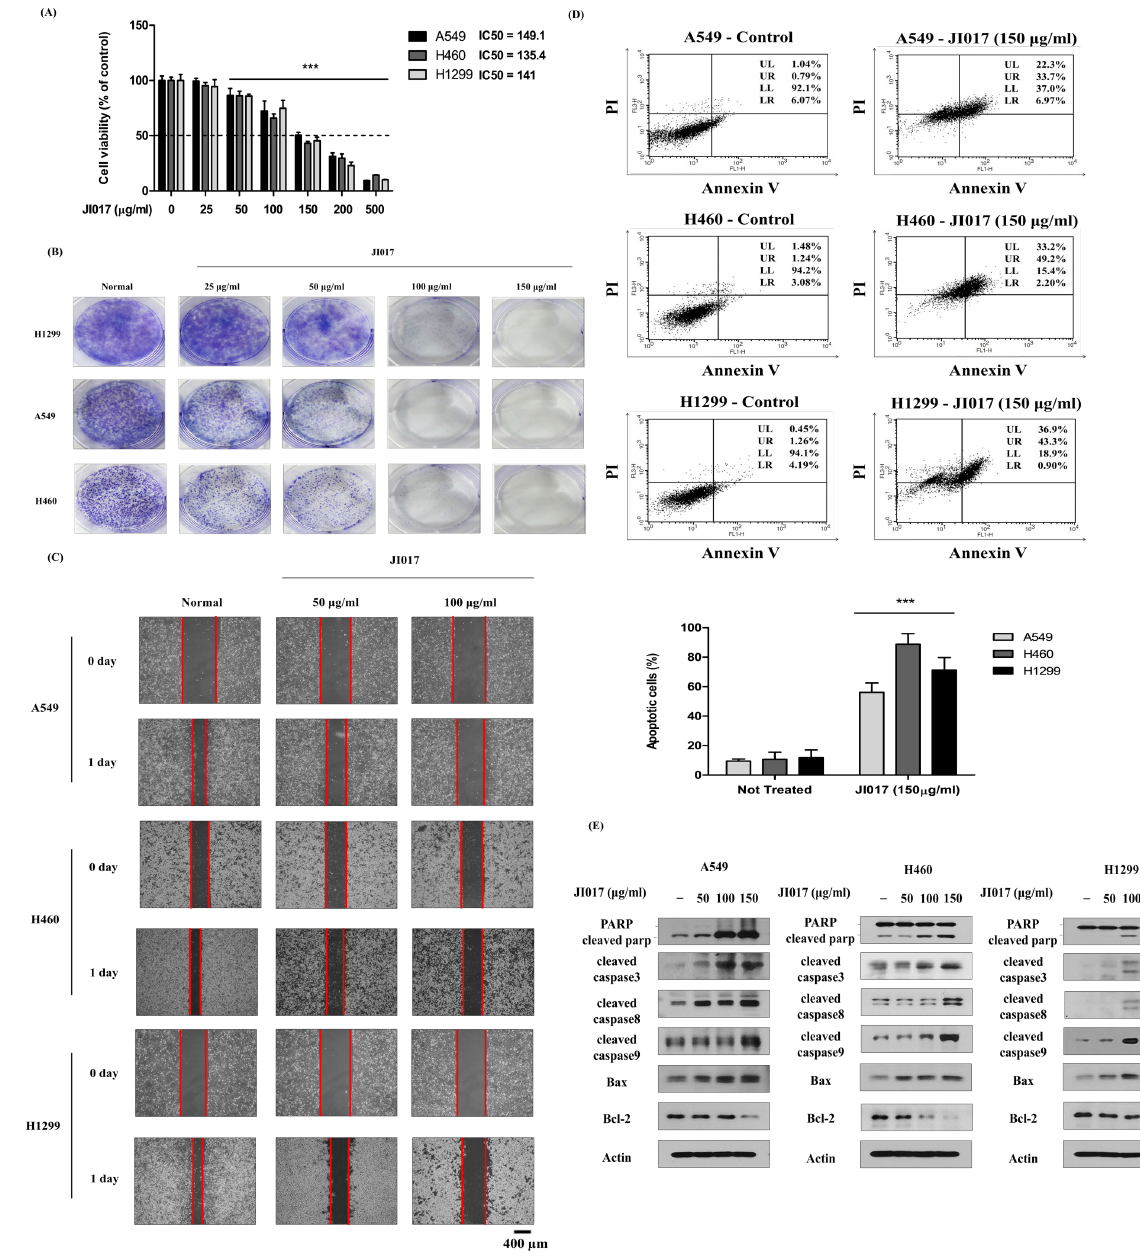
Figure 1. Effect of JI017 on A549, H460, and H1299 cell viability. ( A ) Cells were treated with different concentrations of JI017 for 24 h. ( B ) Cell viability was then measured using the MTS assay. H460, A549, and H1299 cells were treated with JI017 and exposed for 7 days, then the effect on cell growth was assessed using a colony formation assay. ( C ) The migration of JI017-treated cells was assessed using a wound-healing assay. Intervals between cells are marked with red lines. Scale bar = 400 µ m. ( D ) H460 and H1299 cells were treated with JI017 for 24 h, stained with Annexin V/PI, and analyzed by flow cytometry. ( E ) Whole cell lysates were analyzed by Western blotting with anti-PARP; anti-cleaved caspase 3, -8, and -9; and anti-Bax, anti-Bcl-2, and anti-Actin antibodies. Data are presented as the mean ± SEM. *** p < 0.001 compared to untreated cells.